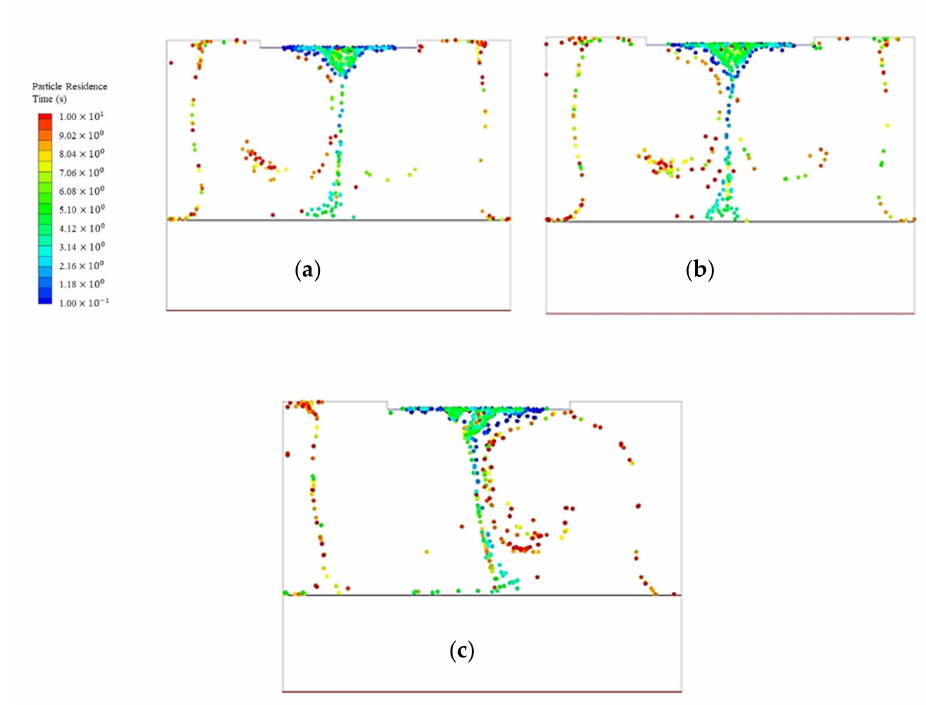
Figure 7. Inclusion distribution with different electrode vibrating frequency ( a ) 0.25 Hz ( b ) 0.5 Hz and ( c ) 1